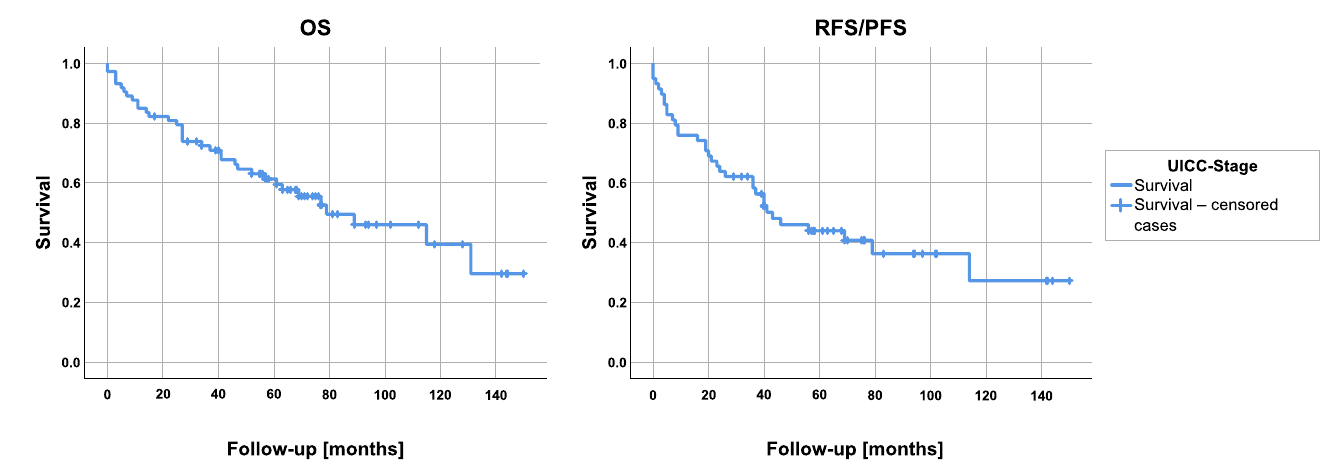
Figure 1. Overall survival (OS) and recurrence/progression-free survival (RFS/PFS).